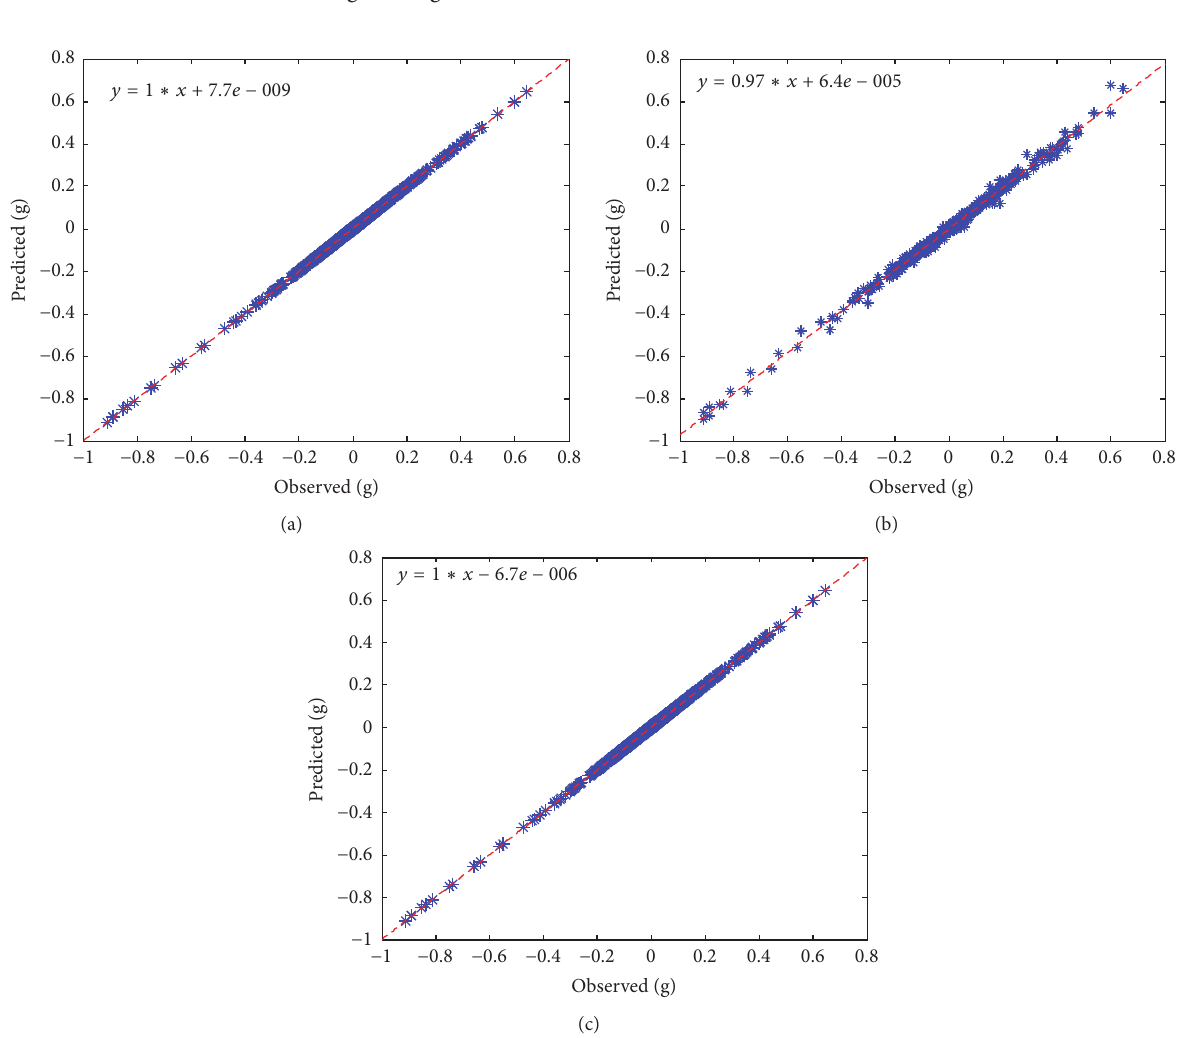
1.85𝑒−5 , 6.94𝑒−2 , and 7.70𝑒−2 g, respectively. Moreover,